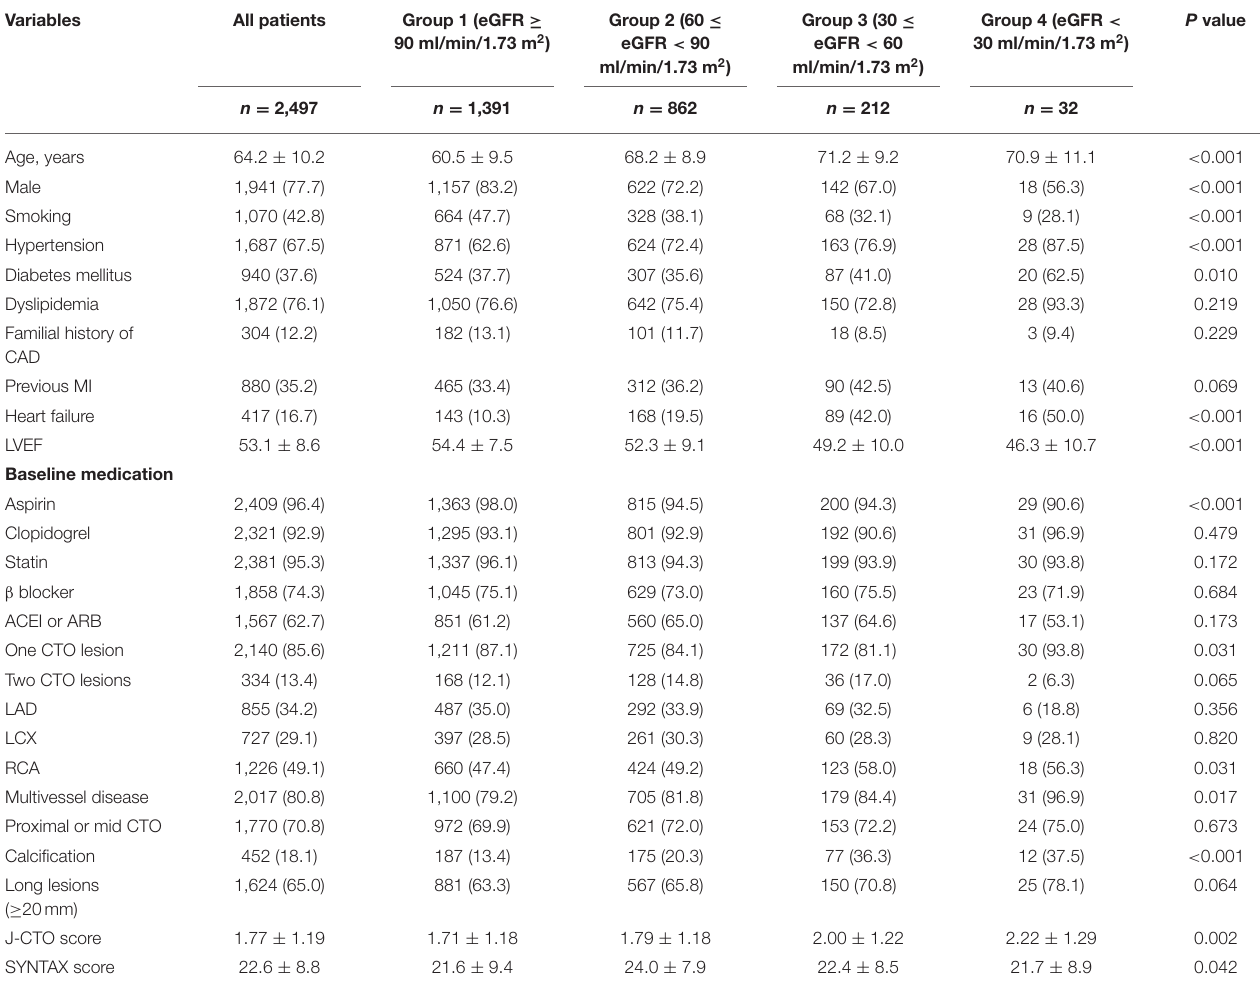
TABLE 1 | Baseline clinical and angiographic characteristics of all patients stratified by eGFR.